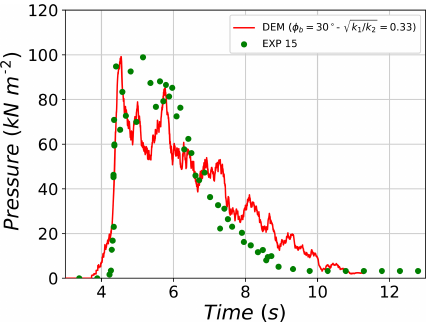
Figure 20. Evolution of pressure on the large plate for test no. 15 and its respective DEM best-fit simulation.